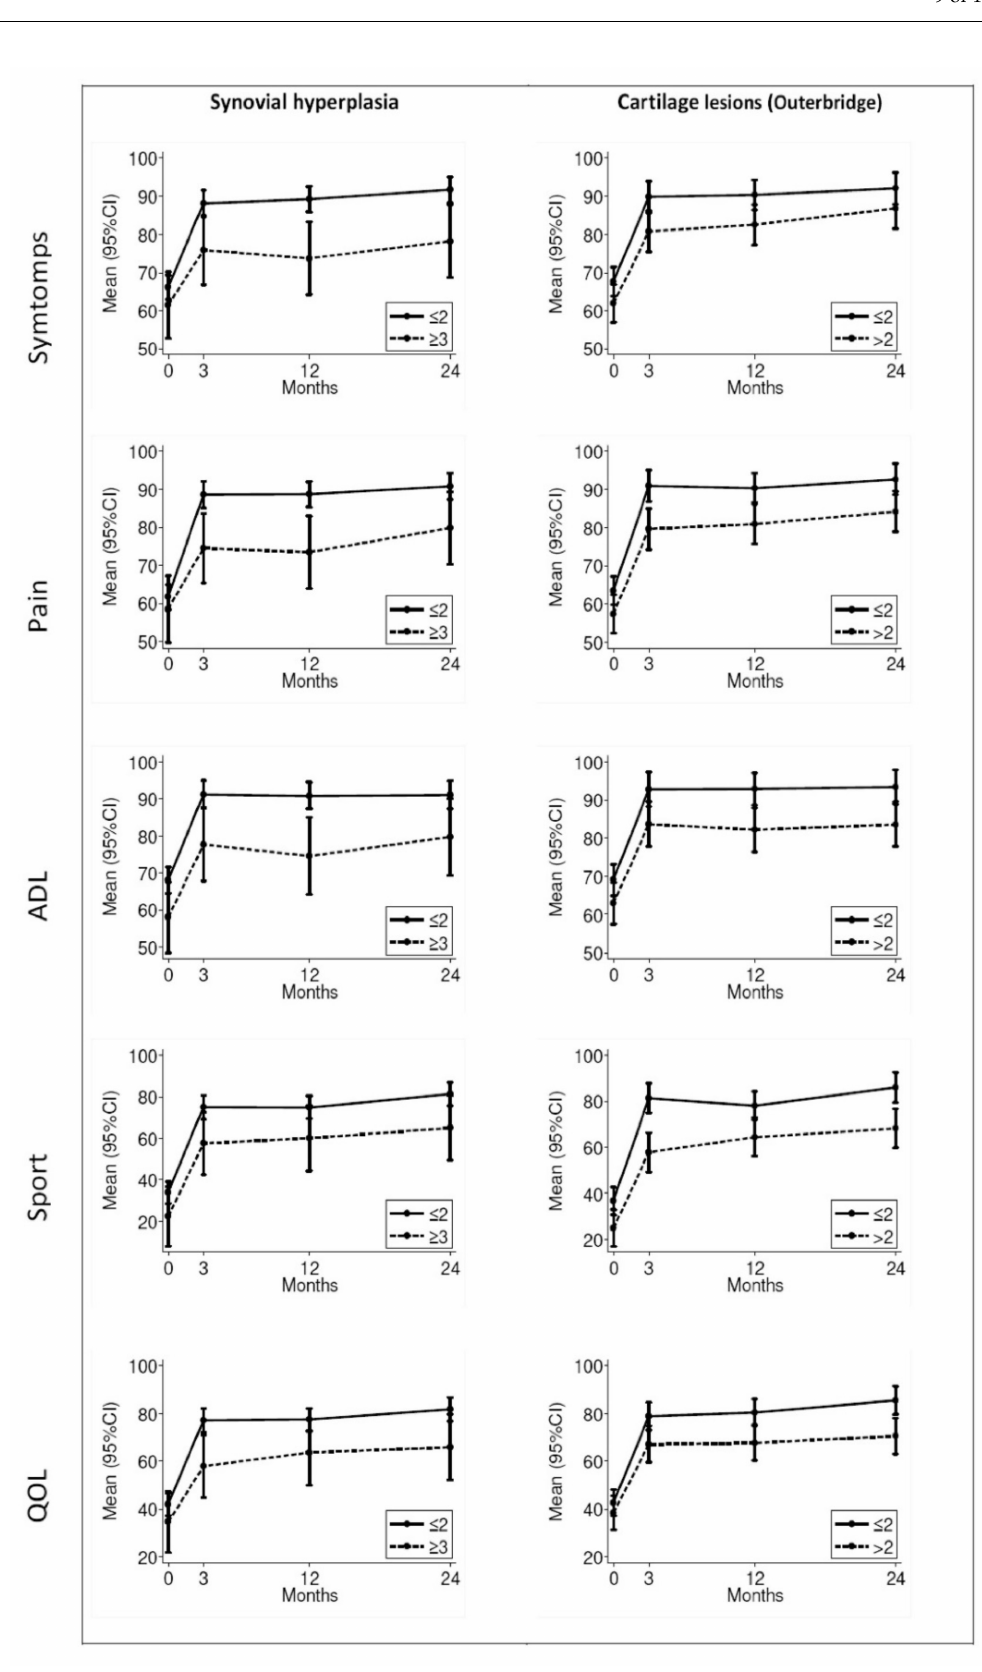
Figure 1. Mean (95% CI) KOOS subscale changes during post-surgery follow-up in patients with high and low grade of suprapatellar synovial hyperplasia ( ≤ 2 vs. > 3) and cartilage lesions ( ≤ 2 vs. >2) (ADL = Function in daily living; QOL = Knee-related quality of life; CI = confidence